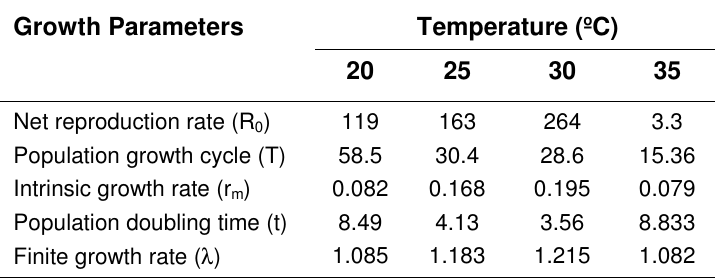
Life Table Parameters of P. dubia at Different